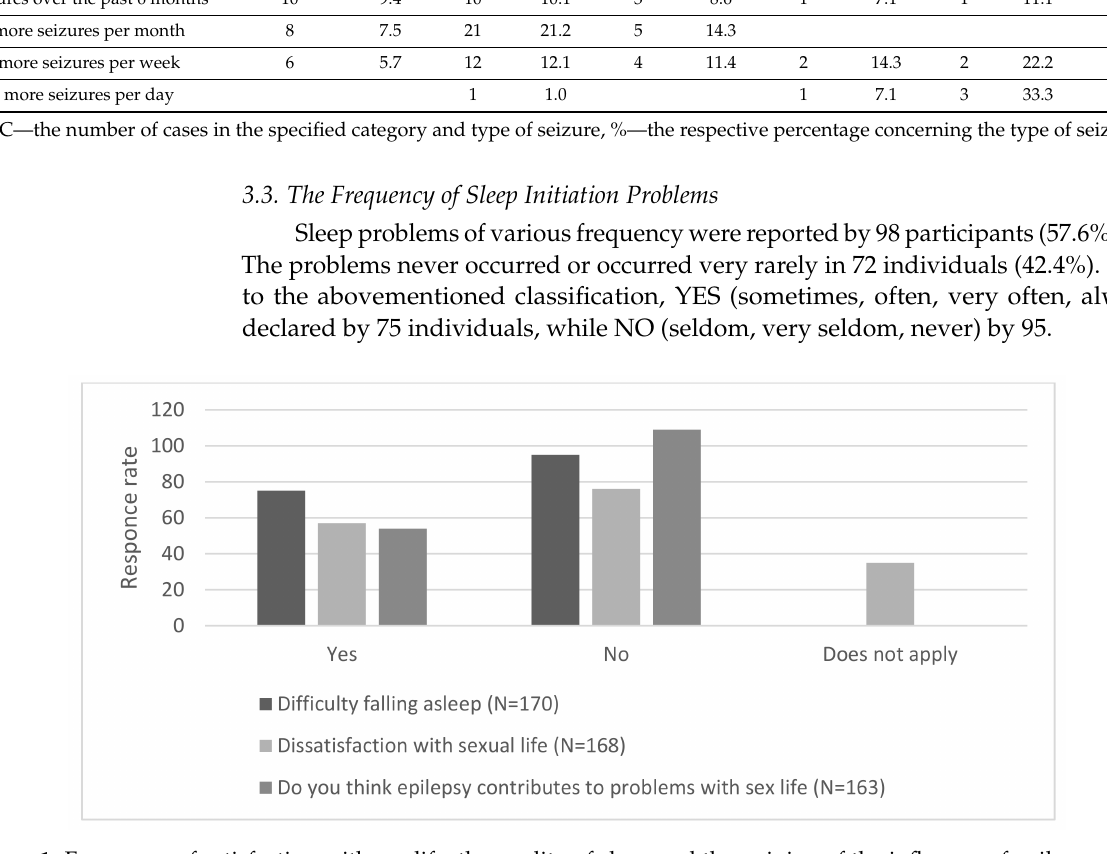
Figure 1. Frequency of satisfaction with sex life, the quality of sleep and the opinion of the influence of epilepsy on the quality of sex life and the subject’s